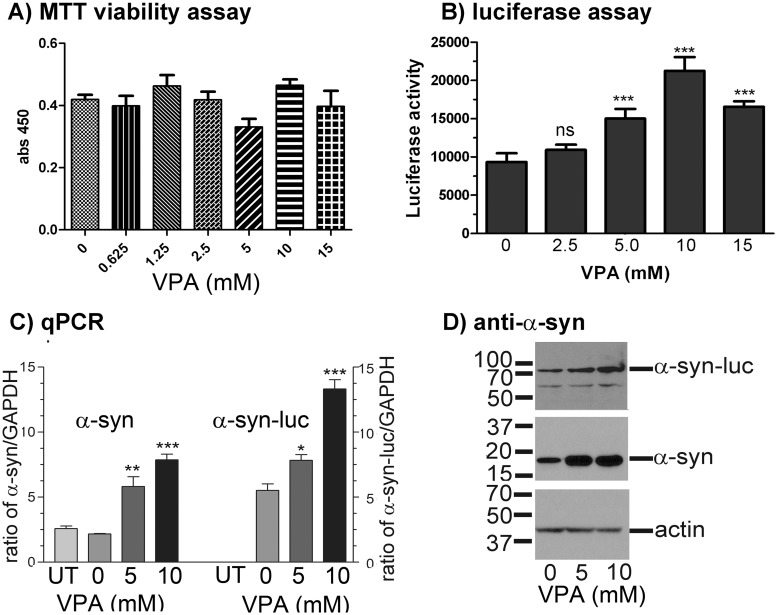
Effects of VPA treatment on α-syn-luc expression in the Luc6B cell line.
(A) MTT viability assay of Luc6B cells (n = 4). Cells were plated in 384-well tissue culture plate in DMEM/FBS containing the indicated VPA concentration, and grown for 72 hours. Luc6B cell growth was not significantly affected by VPA concentration. (B) Luciferase assay of VPA treated cells. n = 4. Luciferase activities increased with increasing concentrations of VPA in Luc6B cells. Luciferase activity was expressed as Mean ± SD. (C) qPCR and (D) Western blots of mRNA and protein extracted from VPA-treated Luc6B cells. The ratio of both α-syn/GAPDH and α-syn-luc/GAPDH mRNA increased significantly with increased concentrations of VPA when comparing with mRNA expression of untreated Luc6B cells. UT = untransfected SH-SY5Y cells. Data for luciferase enzymatic activity and qPCR were analyzed by one-way ANOVA, P<0.0001 followed by Tukey’s multiple comparison test. The P values represent the difference between untreated and VPA treated Luc6B cells. * P < 0.05, ** P < 0.01, *** P < 0.001.